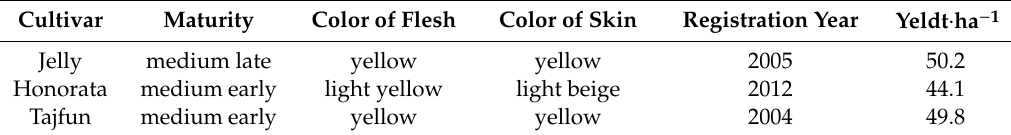
Table 1. Factor I—Description of potato cultivars grown in the experiment [26].